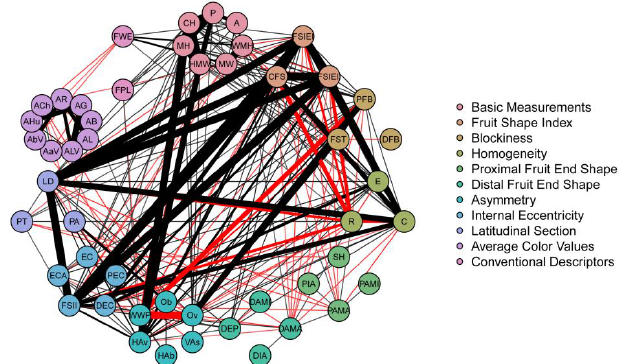
Figure 1. Correlation network depicting relationships among fruit descriptors. Acronyms can be found in Table S5. Each specific color represents one of the 10 categories described by TA software and the two analyzed conventional parameters (FWE and FPL). The width of bands is proportional to the correlation coefficients. Positive correlations are shown in black, while negative ones appear in red. Only significant coefficients ( p < 0.05) higher than ±0.5 are represented.